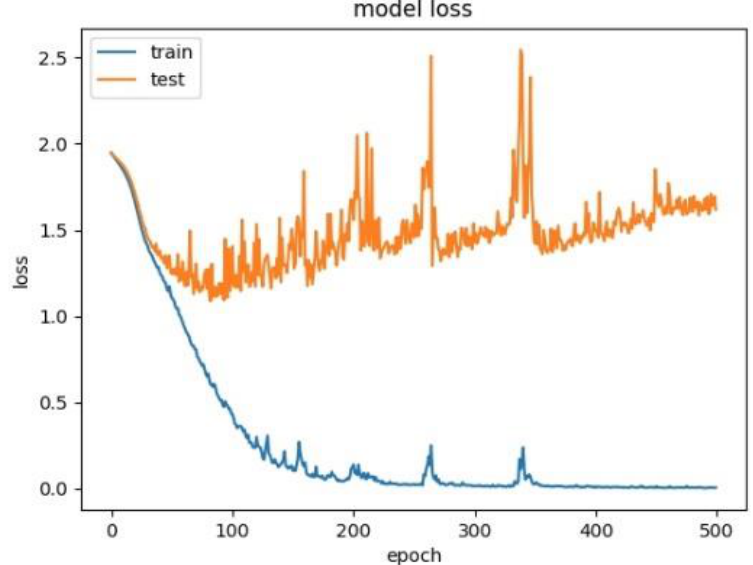
Figure 18. Model loss for CNN+LSTM×2+Self-Attention. Table 3. The accuracy of the models set in this paper.